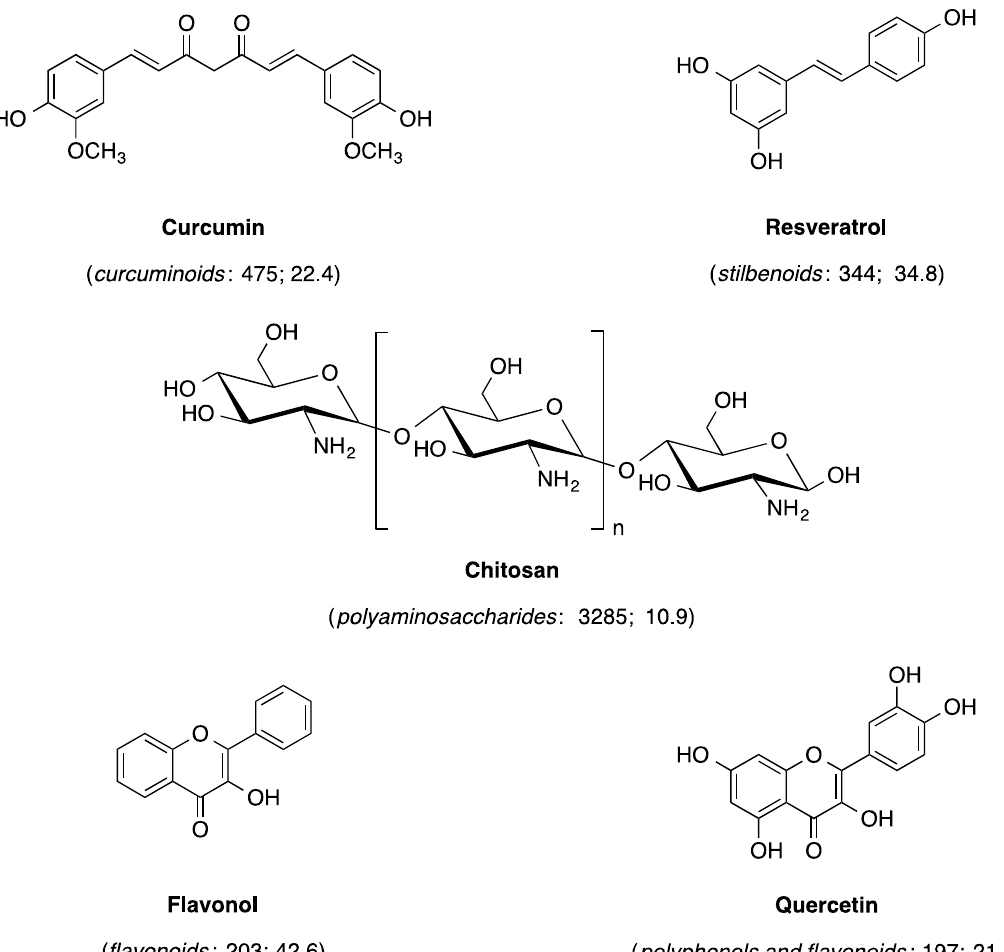
Figure 3. Chemical structures of key single chemicals or representatives of chemical classes that were often discussed in the evaluated curcumin publications. The cited compound classes ( italic ), number of publications and citations per publication for each chemical or representative chemical class are given in brackets.